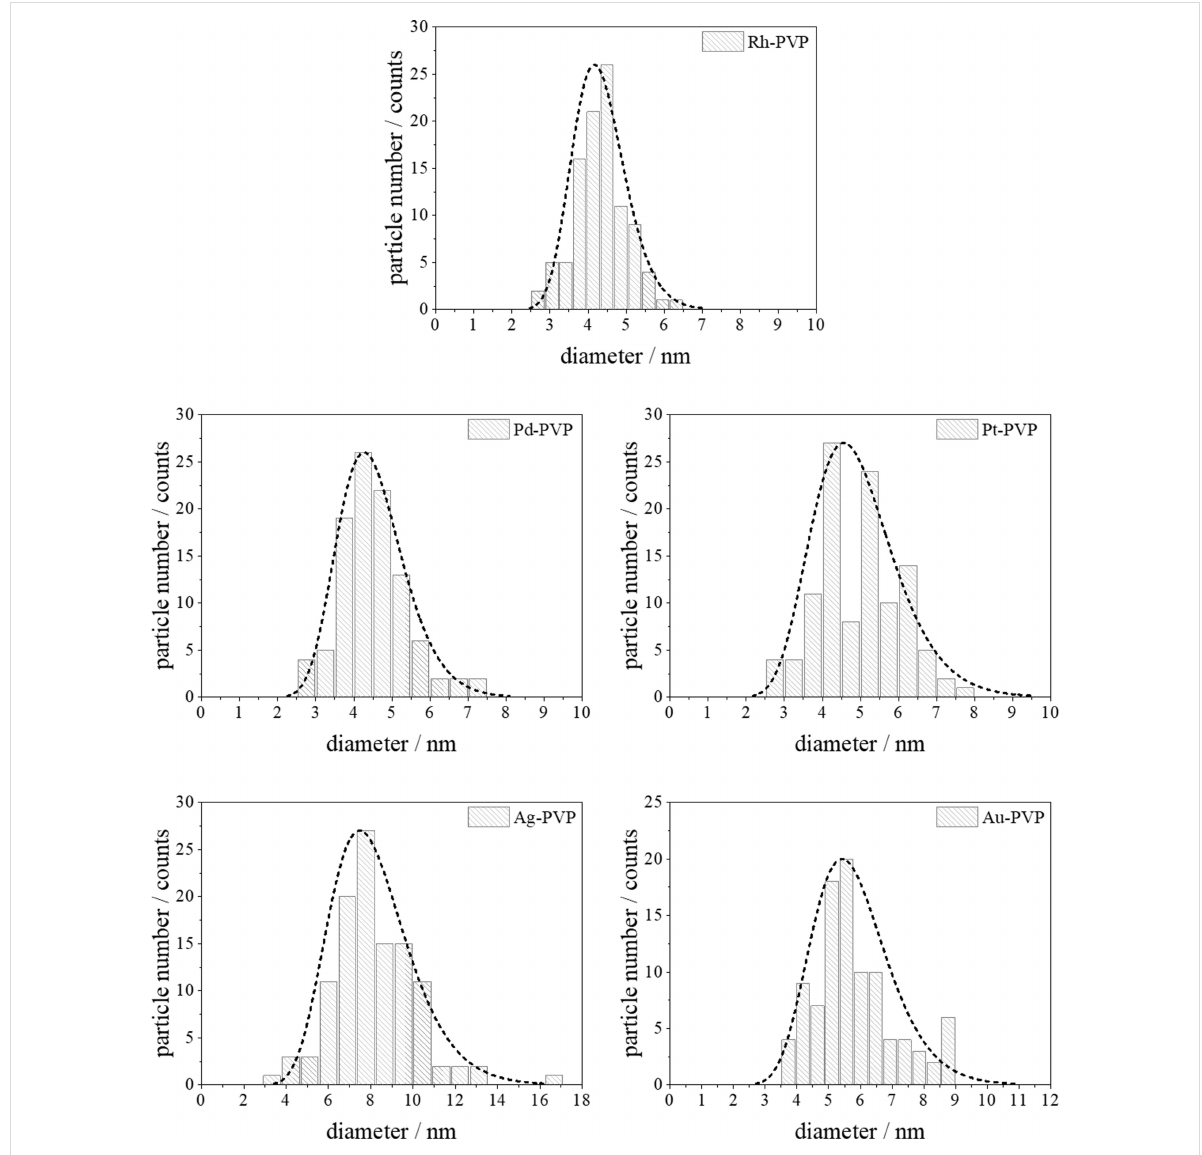
Figure 4: Particle size distributions of noble metal nanoparticles determined by high-resolution TEM imaging (HRTEM; log-normal particle size distri- bution fit). The histograms were analysed using a log-normal distribution fit to determine the number-weighted